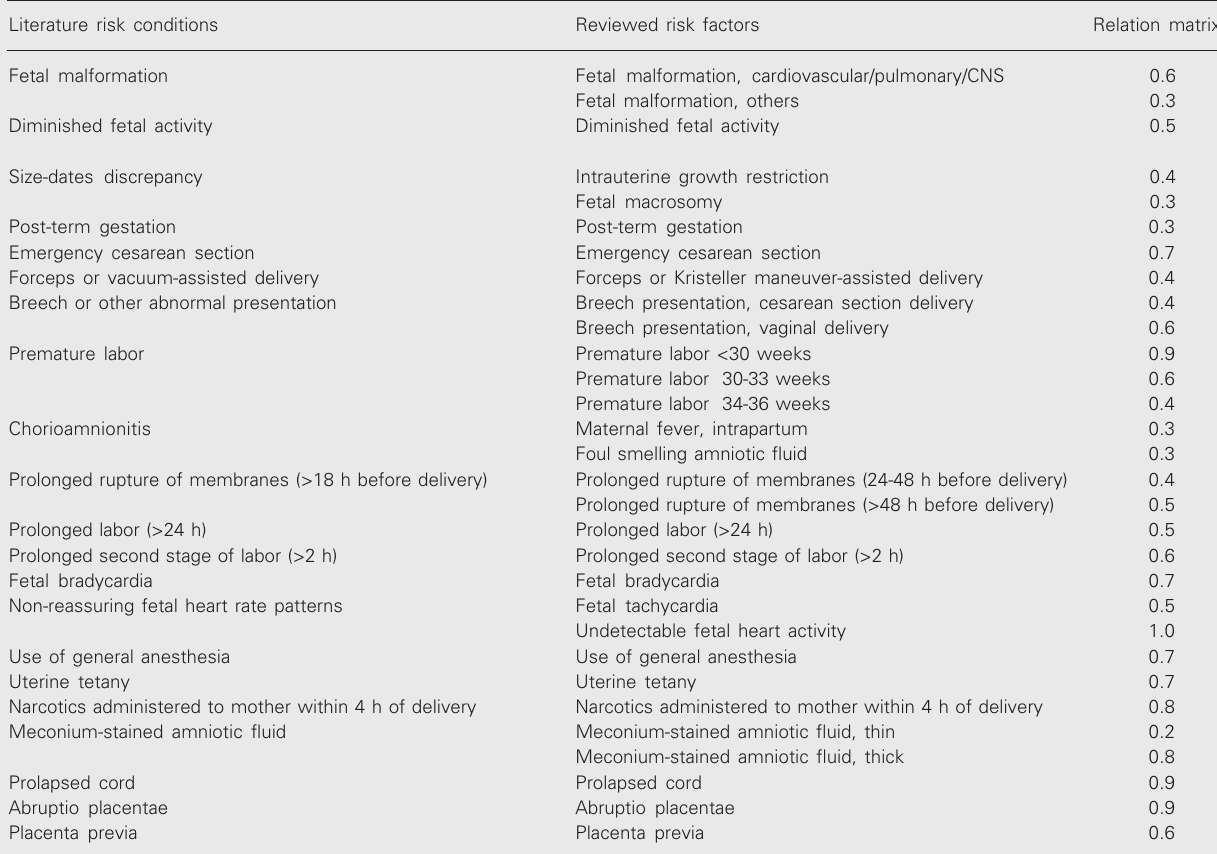
Table 3. Analysis of fetal and perinatal risk